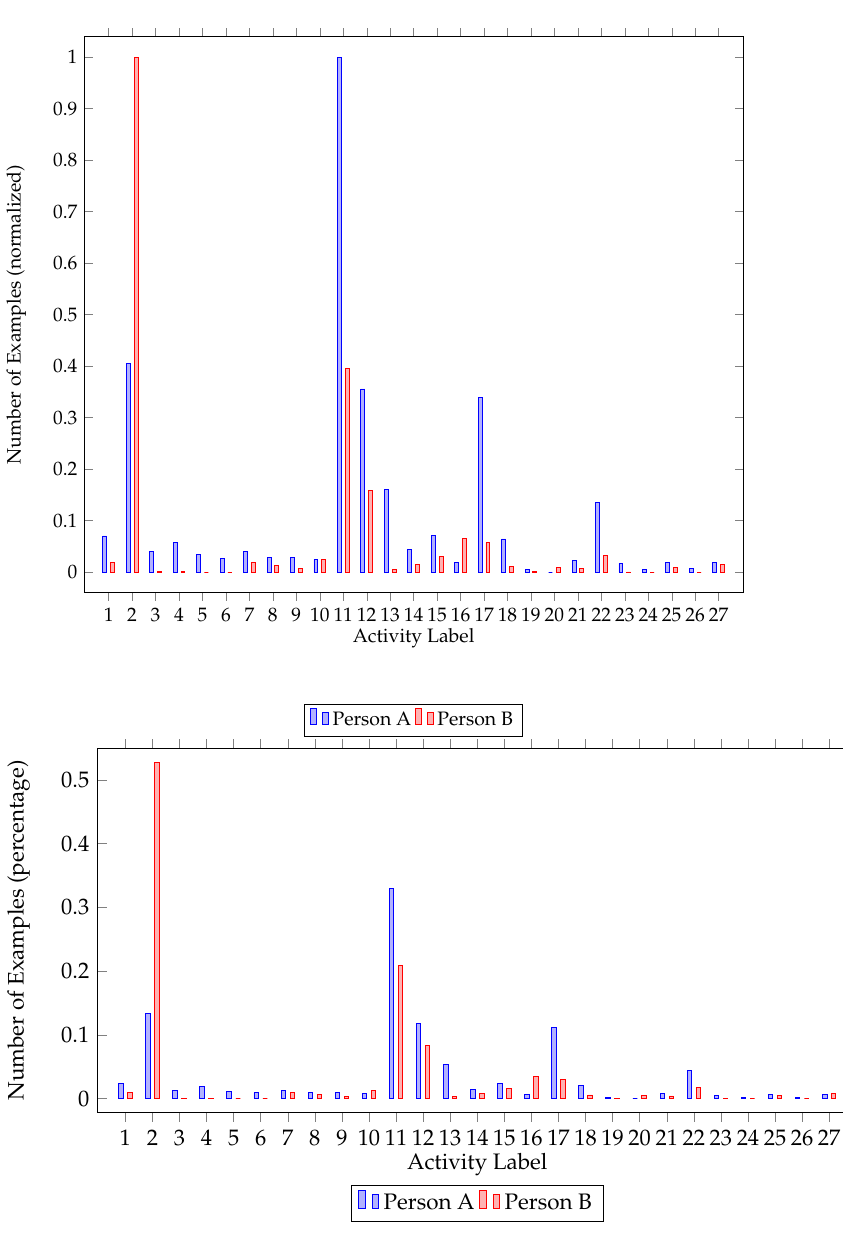
Figure 1. House A class imbalance. Number of classes per resident (normalized) and percentage of each class for the first